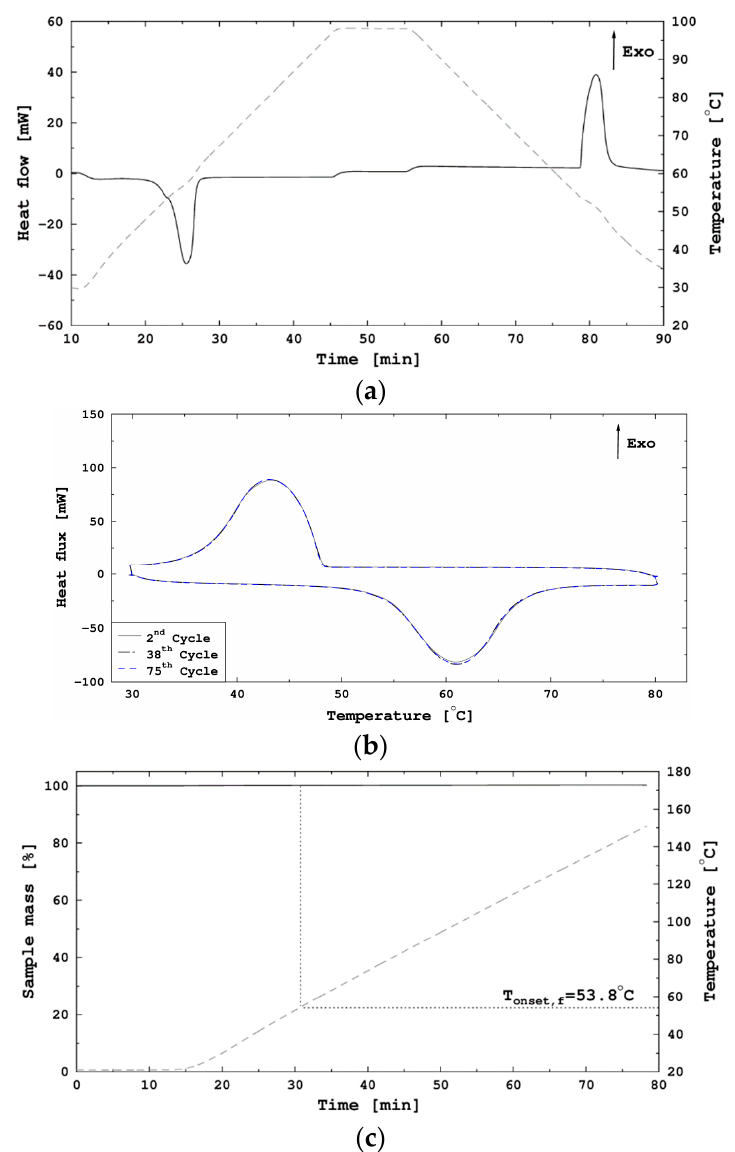
Figure 1. SA–PA mixture thermal analysis: ( a ) DSC determination of transition temperature and enthalpy (Setaram DSC131, sample mass 32.324 ± 0.004 mg), ( b ) DSC cycling (Perkin-Elmer Pyris Diamond, sample mass 11.080 ± 0.004 mg) and ( c ) TG analysis (Setaram SETSYS).